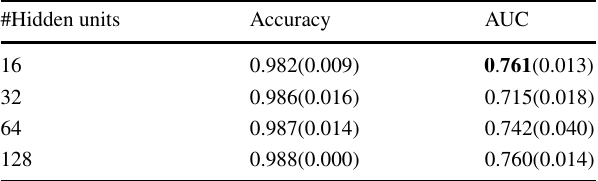
Here the number of hidden units in the LSTM on FIN is 16, and the resampling ratio is Table 6 The results of different numbers of hidden units of LSTM (FIN) in DMDP with LSTM (FIN) + Wavenet (TEXT)